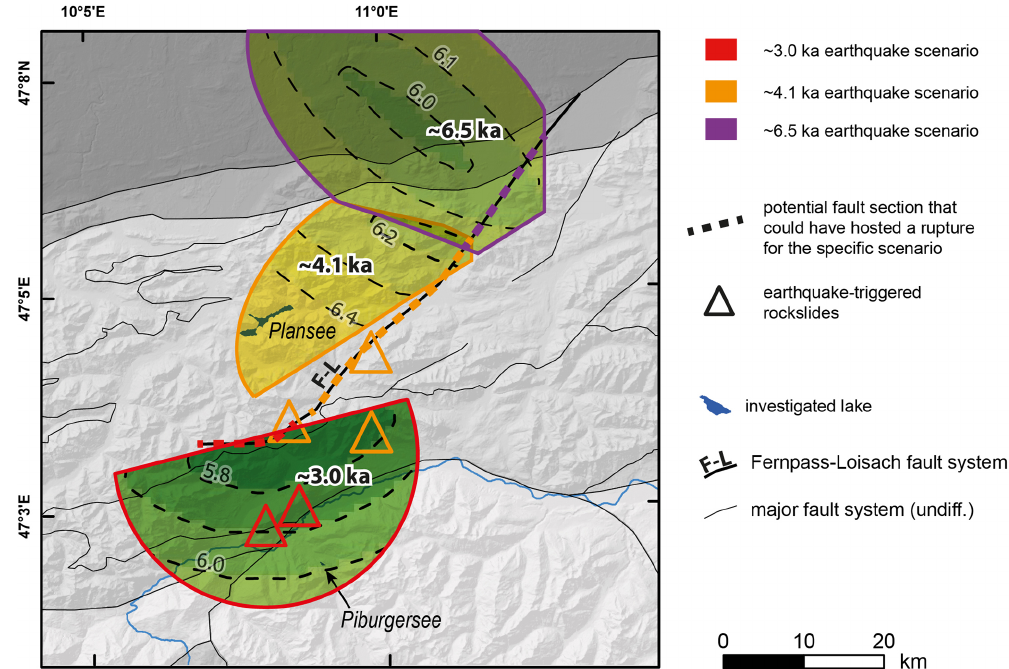
Figure 8. Potential NE–SW migration of severe earthquakes between ∼ 6 . 5 and ∼ 3 . 0ka (paleo-earthquake scenarios A, B, and C) might indicate a progressive failure of the Fernpass–Loisach Fault. Solutions for the source area and minimum magnitude are derived from the inverse application of an IPE using the lacustrine paleoseismic evidence in a grid-search analysis (see Sect. 5.2 and Fig.